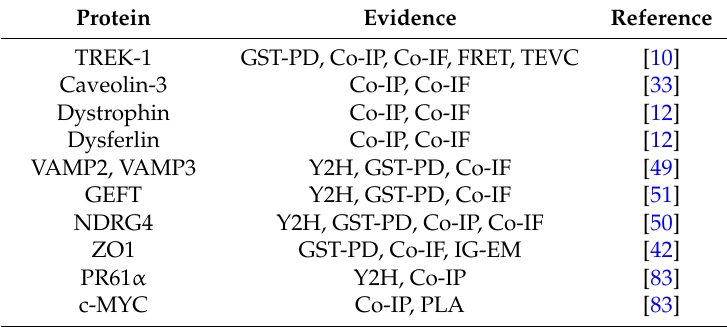
Table 2. Popdc interaction